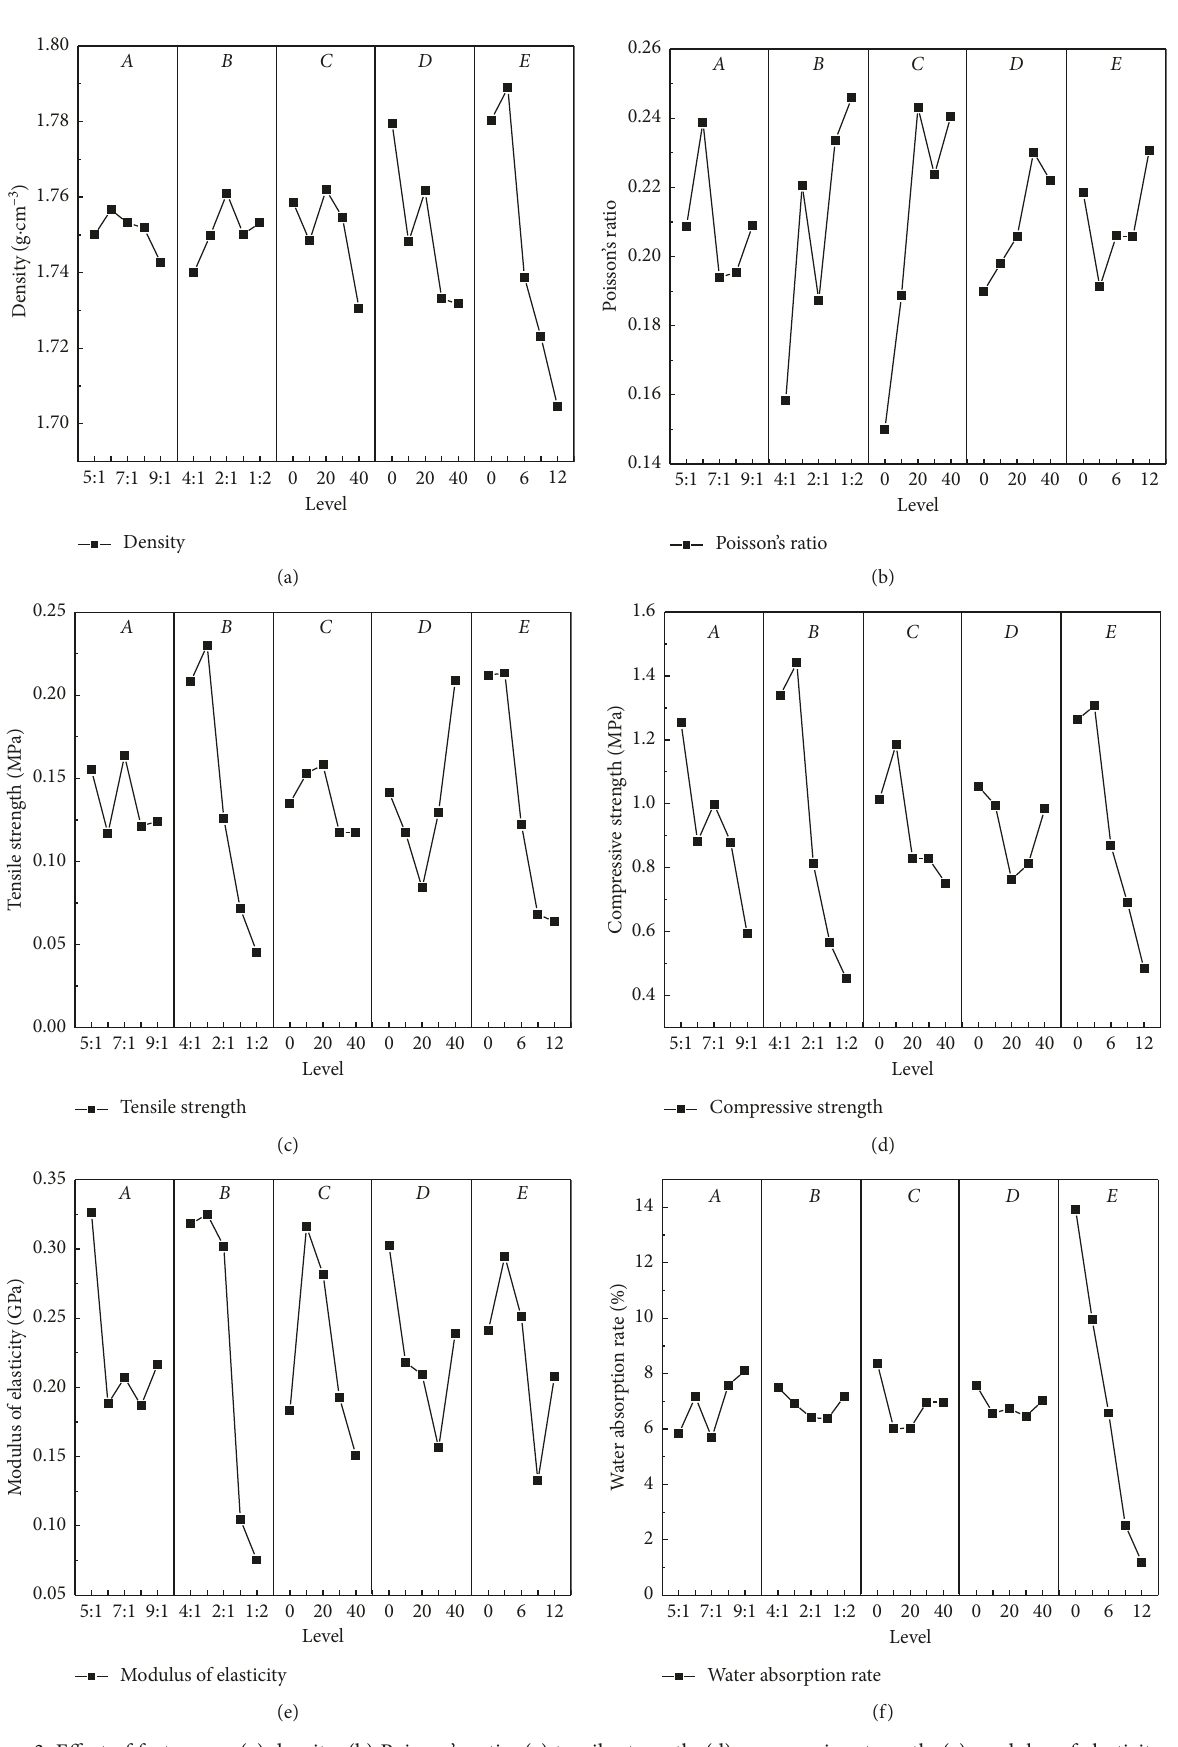
Figure 3: Effect of factors on: (a) density, (b) Poisson’s ratio, (c) tensile strength, (d) compressive strength, (e) modulus of elasticity, and (f) water absorption